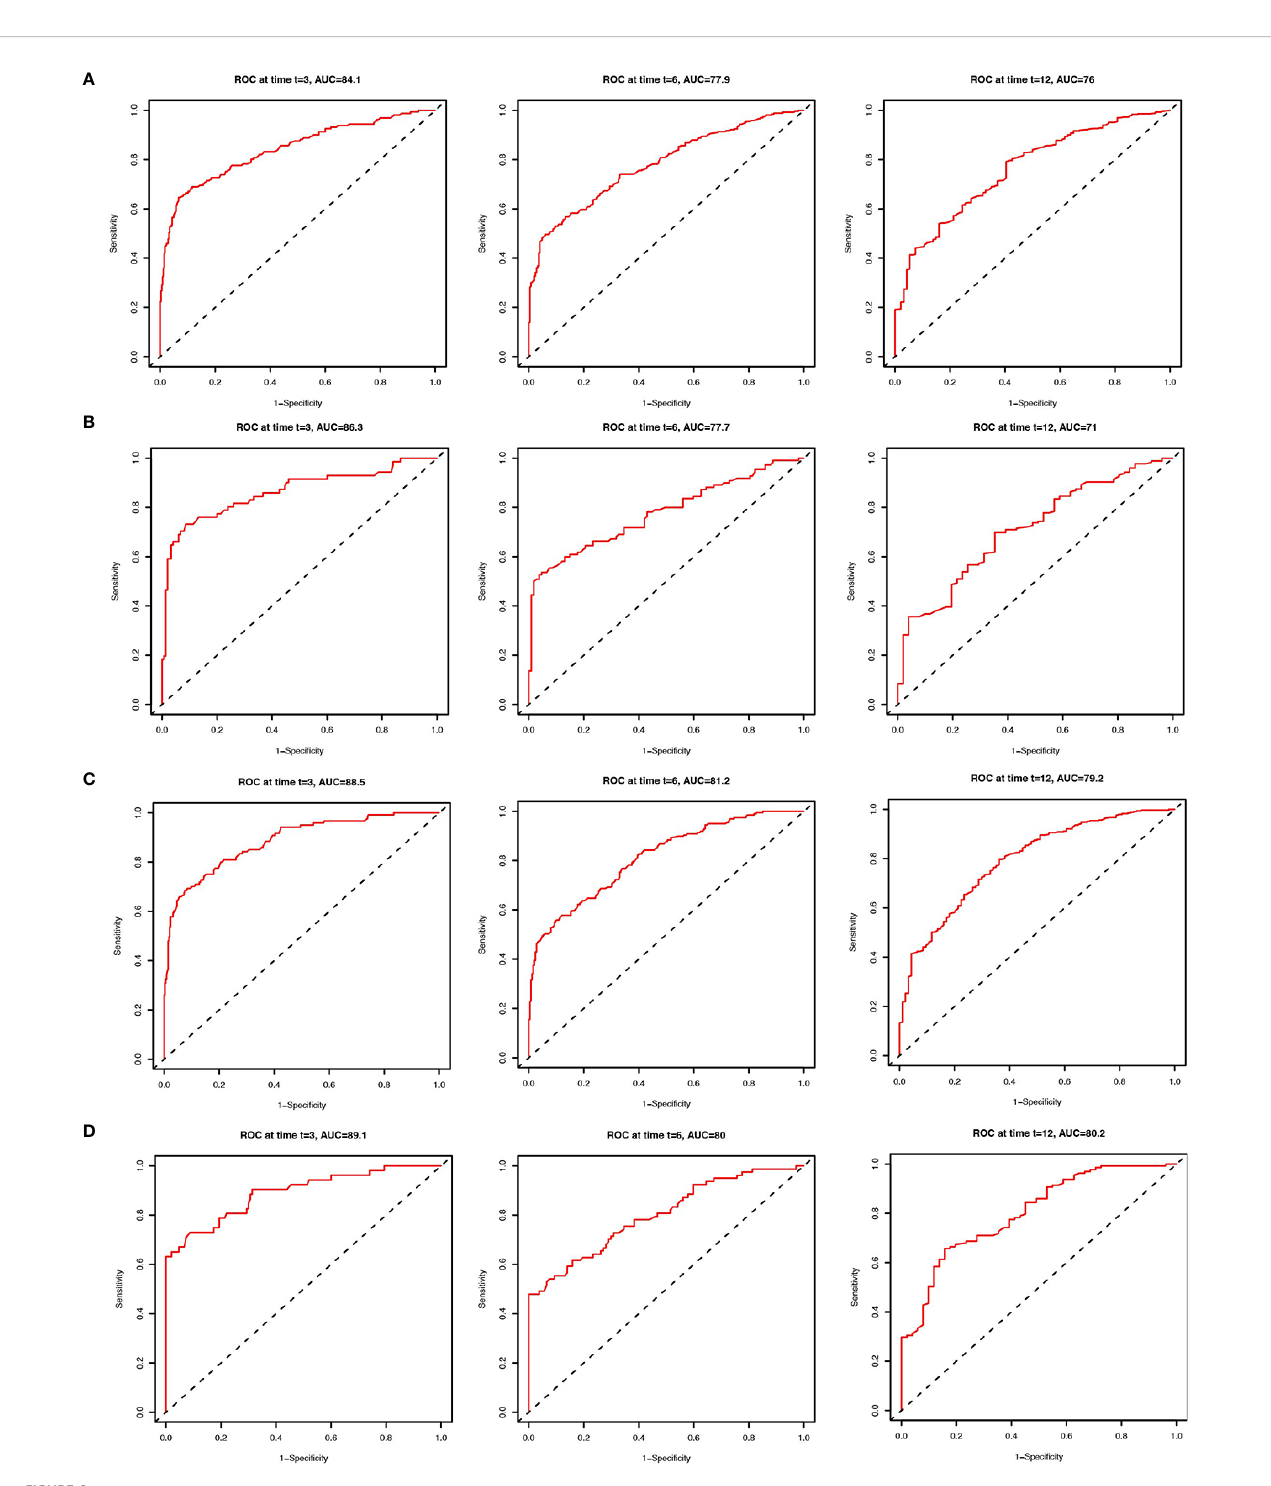
FIGURE 6 ROC curves to predict 3-month, 6-month and 12-month overall survival of SCLC patients with BM in the training cohort (A) and validation cohort (B) . ROC curves to predict cancer-speci fi c survival in SCLC patients with BM in the training cohort (C) and validation cohort (D)